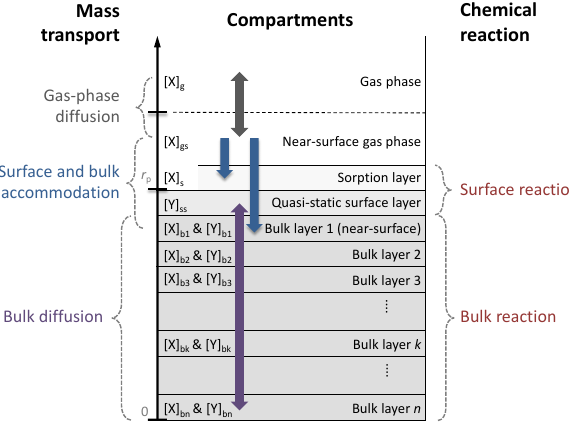
Fig. 1. Processes and compartments discussed in this paper (adapted from Shiraiwa et al., 2010), assuming a system which is either pla- nar or spherically symmetric. Key processes are highlighted. Dif- fusion of gaseous trace gas X is assumed to influence the near sur- face gas-phase concentration [X] gs within one mean free path λ x of the particle surface ( r p ). Following P¨oschl et al. (2007), surface accommodation denotes the mass flux of X from the near-surface gas phase to the particle surface, whereas bulk accommodation also includes the subsequent transport into the near-surface bulk. Sur- face reaction occurs within or between the sorption layer and the quasi-static surface layer consisting of bulk material Y. Reaction and diffusion can take place in n individually resolved bulk layers. All symbols are defined in Table A1.